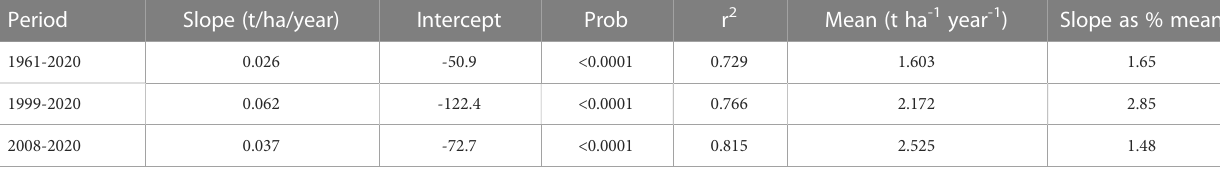
TABLE 9 Regression of estimated national average maize grain yields in Uganda, onto a baseline year over three periods.